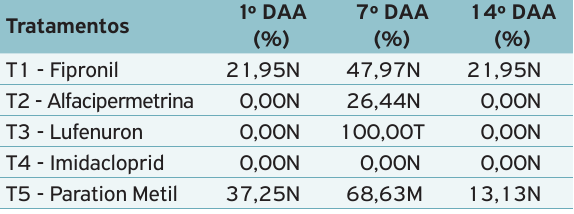
Tabela 7. Porcentagem (%) de redução das populações de himenópteros parasitoides na cultura do algodão